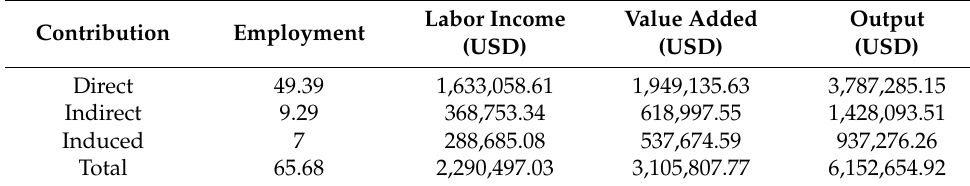
Table A15. Total Contribution of South Slough to Coos County (Annual).